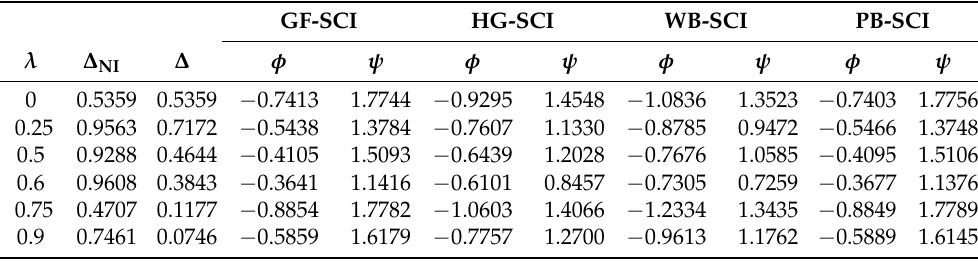
Table 6. Lower limits of the approximate 95% one-sided simultaneous confidence regions of ( φ , ψ ) for the GF-SCI, HG-SCI, WB-SCI and PB-SCI methods in the mildly asthmatic study. GF-SCI HG-SCI WB-SCI PB-SCI λ ∆ NI ∆ φ ψ φ ψ φ ψ φ ψ 0 0.5359 0.5359 − 0.7413 1.7744 − 0.9295 1.4548 −